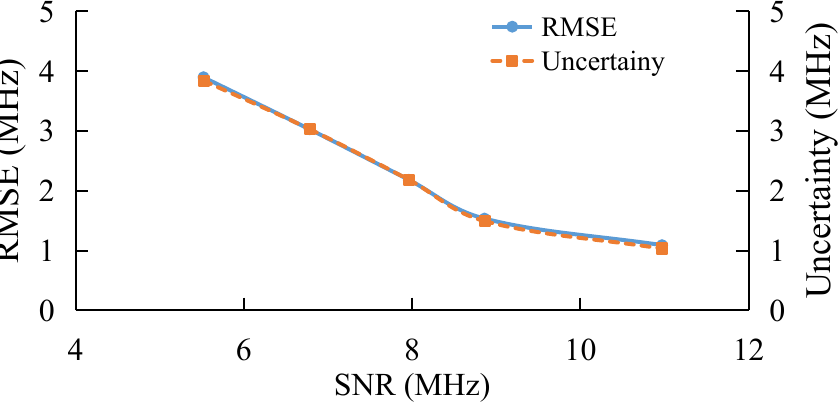
Figure 9. Experimental results under different SNR.